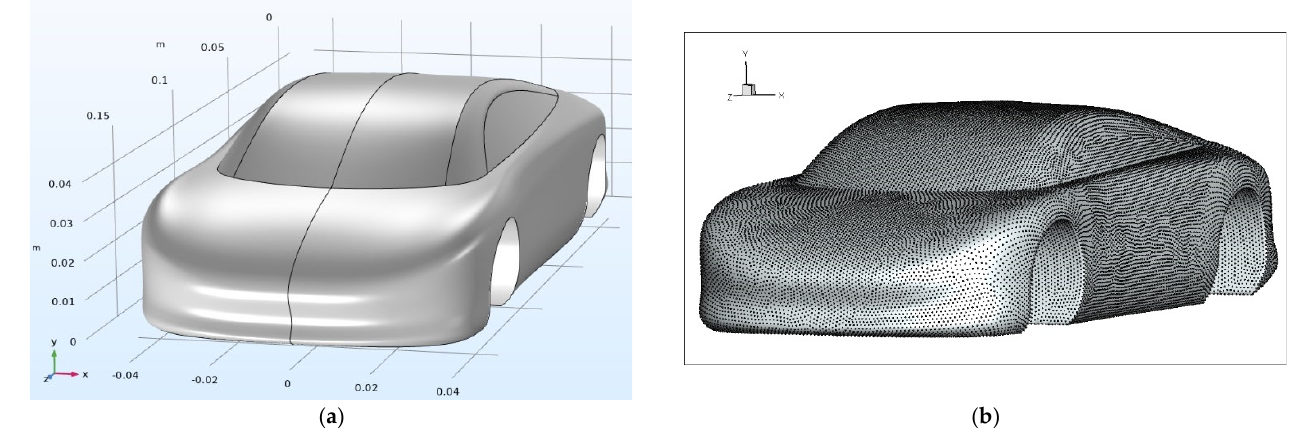
Figure 5. An irregular rigid vehicle model boundary point configuration ( N = 104,896): ( a ) vehicle model; ( b ) boundary points.